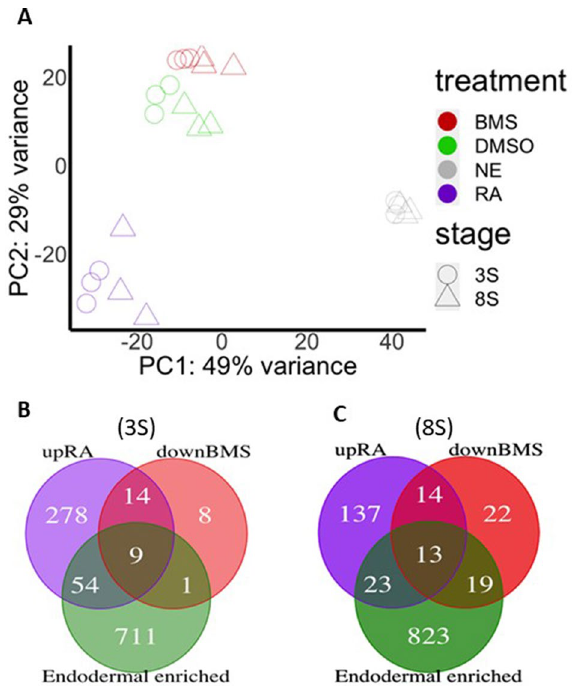
Figure 1. Effect of RA and BMS493 on the transcriptome of endodermal cells. ( A ) Principle component analysis (PCA) of the 24 RNA-seq data obtained on cells isolated at 3-somites stage (circle) and 8-somites stage (triangle). The colors indicate the data for non-endodermal cells (NE) (grey), and endodermal cells treated with RA (purple), BMS493 (red) and DMSO as control (green). The plot shows high reproducibility